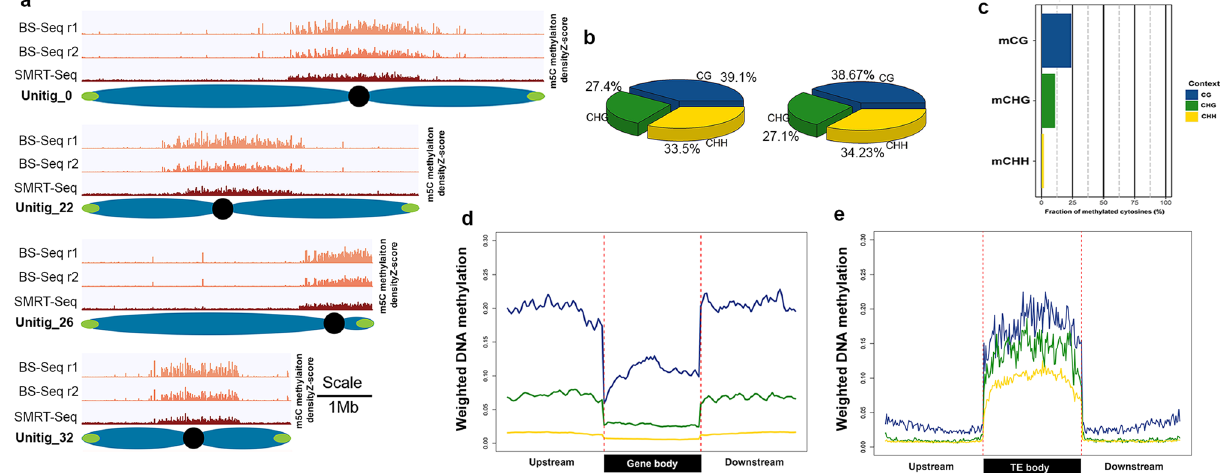
Figure 5. Genome-wide methylation in Utricularia gibba . ( a ) Distribution of methylation (5mC) representation only in the complete chromosomes in U. gibba for location of pericentromeric regions. Here, the blue light red shows the methylation density in BS-Seq replicates and the red histogram represent the methylation distribution in SMRT-Seq with normalized data in Y-axis representing the 5mC density in windows of 100kb (Scale 1Mb). ( b ) DNA methylation level for each context at the genome level. X-axis shown the methylation level according to Schultz et al., 2012. CG methylation in blue, CHG methylation in green, and CHH methylation in yellow. ( c ) Methylation levels for CG, CHG and CHH context. ( d ) Distribution of DNA methylation around all genes. Methylation representation in all contexts (CG, CHG and CHH) 2-kb upstream and downstream. ( e ) TE DNA methylation representation in all contexts (CG, CHG and CHH) 2-kb upstream and